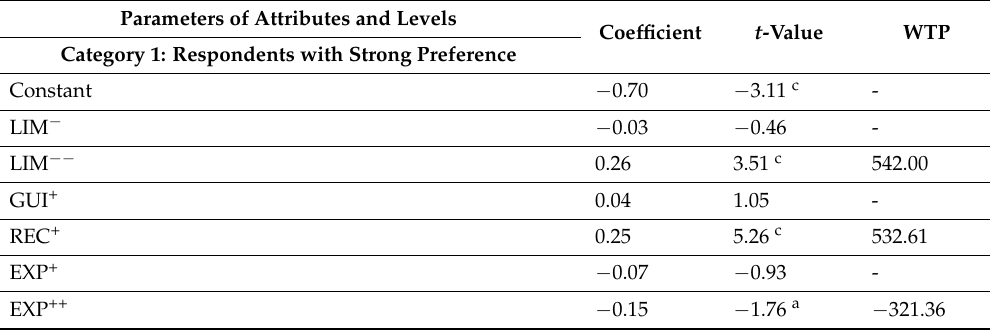
Table 6. Evaluation of latent class model (LCM) variables and WTP evaluation of Orchid